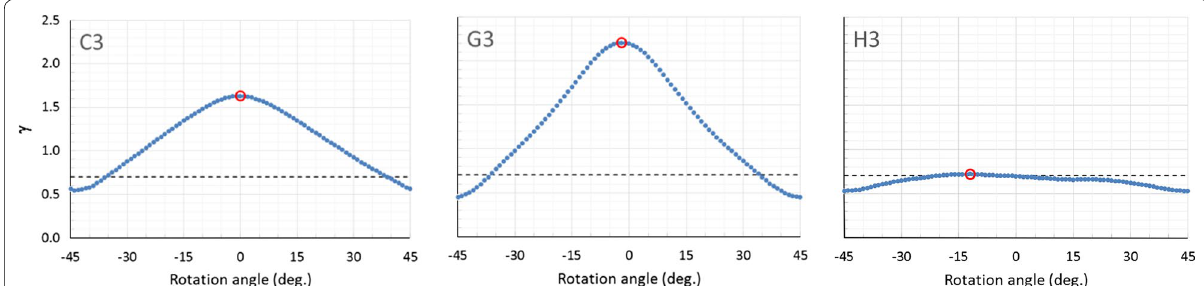
Fig. 10 Transition of γ according to the axes rotation angle. For points C3 and G3, γ is largest close to 0° and remains large over an angular range of about 70°. In contrast, at point H3, γ is relatively small throughout whole angular range